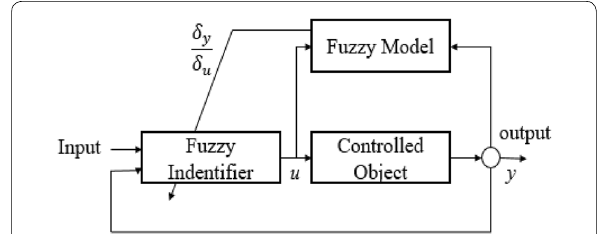
Fig. 5 Adaptive neuro‑fuzzy inference system (ANFIS).